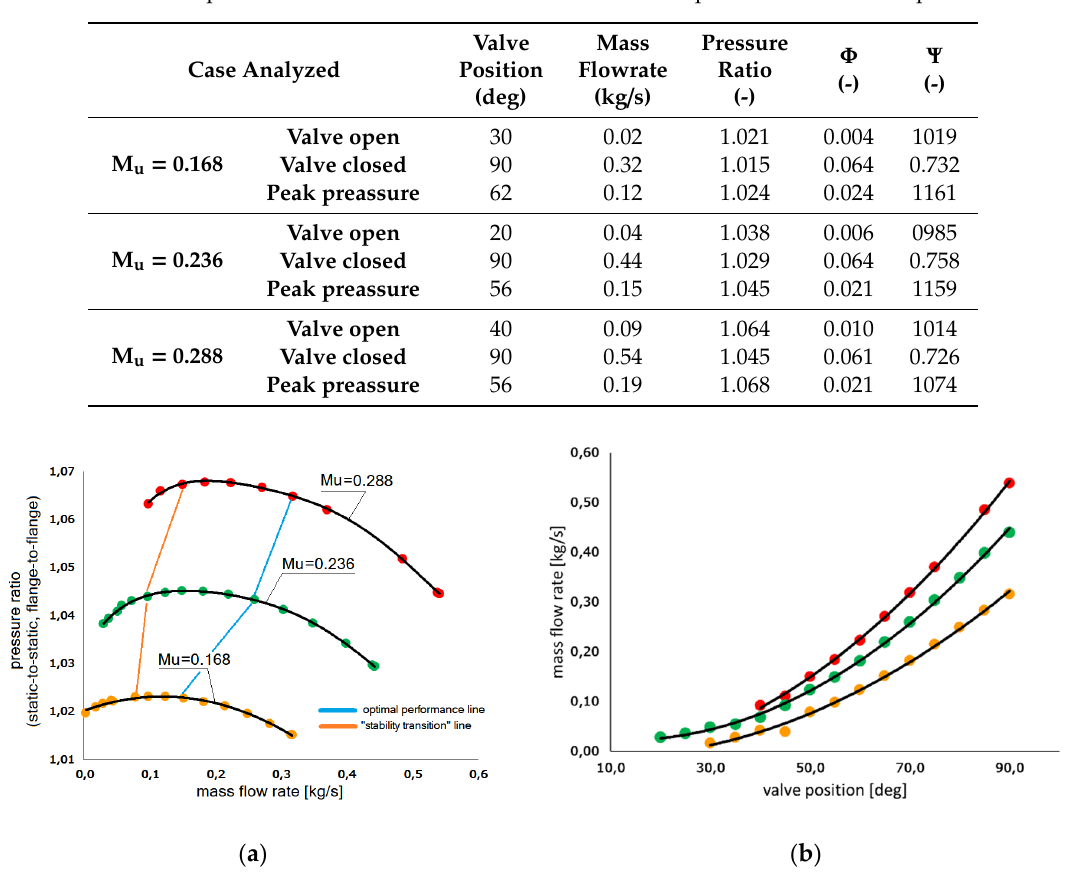
Figure 3. Performance curves and valve characteristics measured at n = 70 Hz (M u = 0.168), n = 95 Hz (M u = 0.236), n = 120 Hz (M u = 0.288). ( a ) Compressor performance curves, ( b ) valve characteristics.